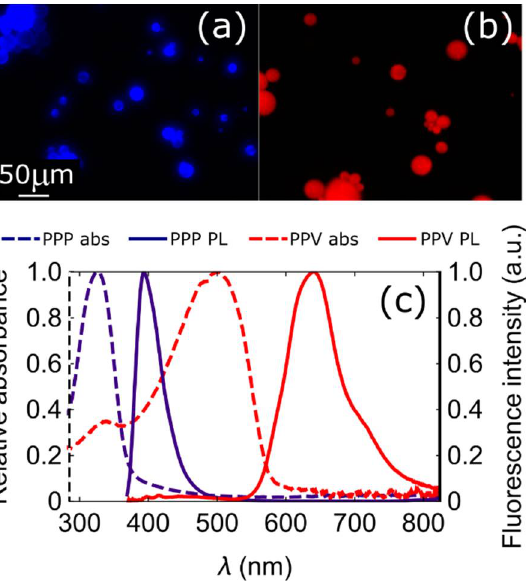
Figure 4. Fluorescence images of MEH-PPP ( a ) and MEH-PPV ( b ) microspheres. ( c ) Absorption and emission spectra of PPV and PPP thin films, and microsphere ensembles, respectively.